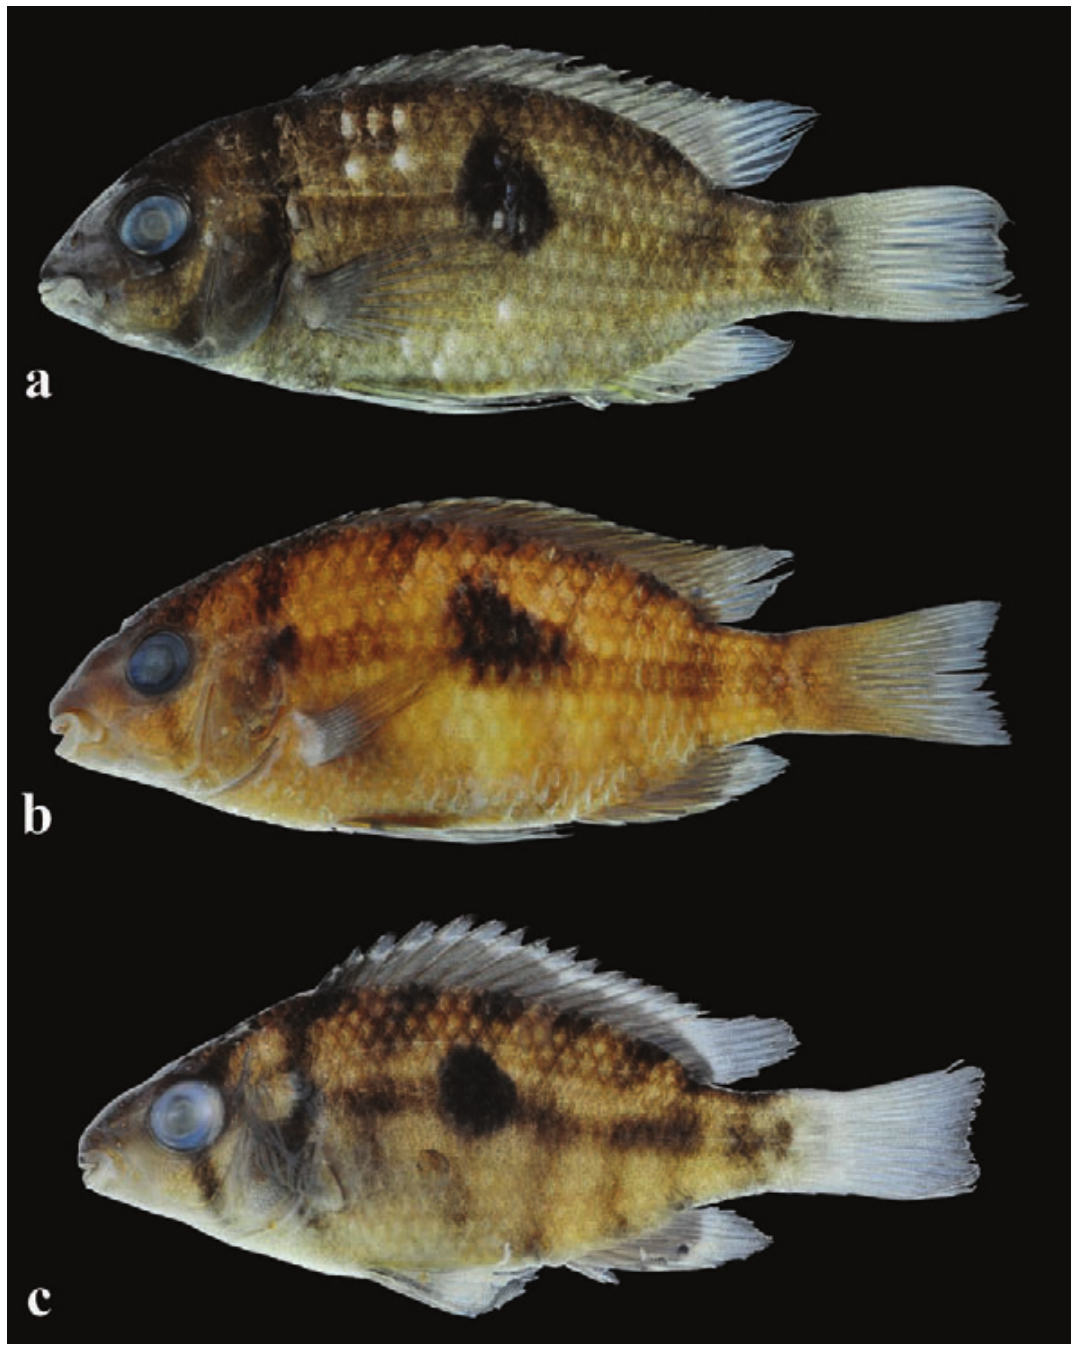
Fig. 5. Ontogenetic changes in body shape and coloration pattern in Mazarunia mazarunii ; a ) same adult individual as shown shortly after capture and anesthetized in Fig. 6a, 76.7 mm SL ROM 89531, b ) 61.2 mm SL ROM 89586, c ) 38.2 mm SL